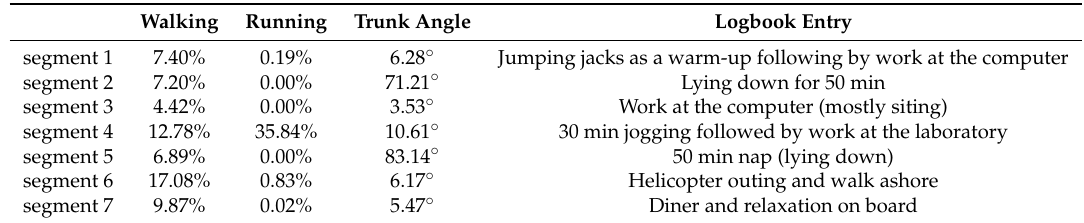
Table 1. Data summary samples for a 1-h expedition